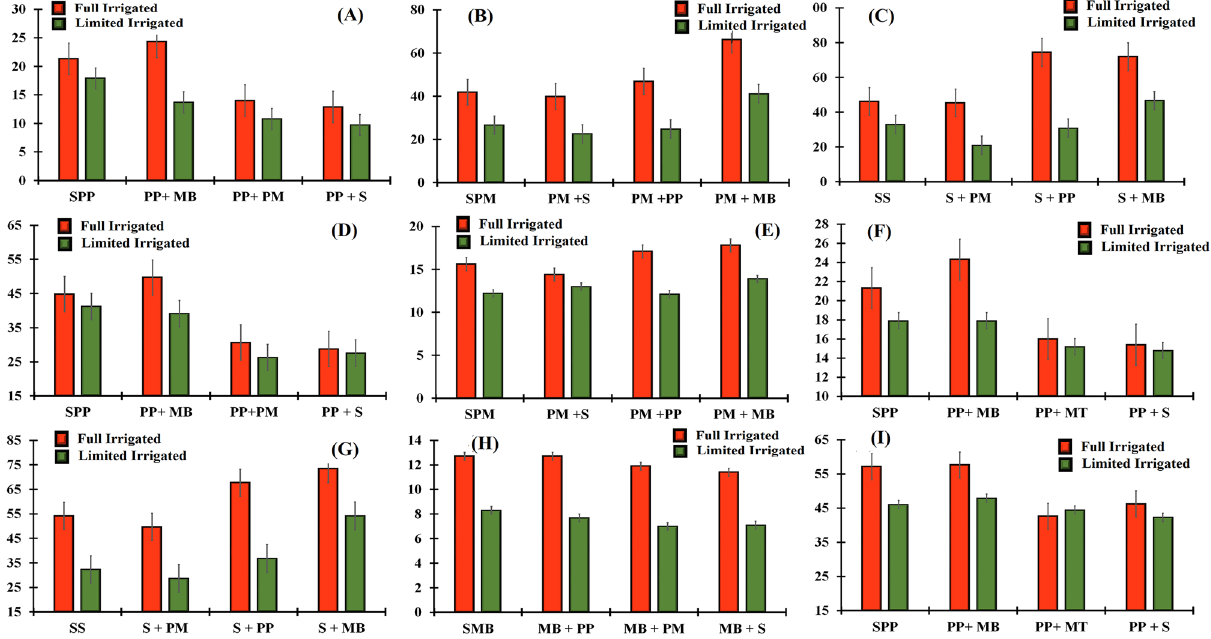
Figure 4. Leaves dry weight of pigeonpea ( A ), stem dry weight of pearl millet ( B ), stem dry weight of sorghum ( C ), stem dry weight of pigeonpea ( D ) at anthesis, respectively, leaves dry weight of pearl millet ( E ), leaves dry weight of pigeonpea ( F ), stem dry weight of sorghum ( G ), stem dry weight of mungbean ( H ), stem dry weight of pigeonpea ( I ) at physiological